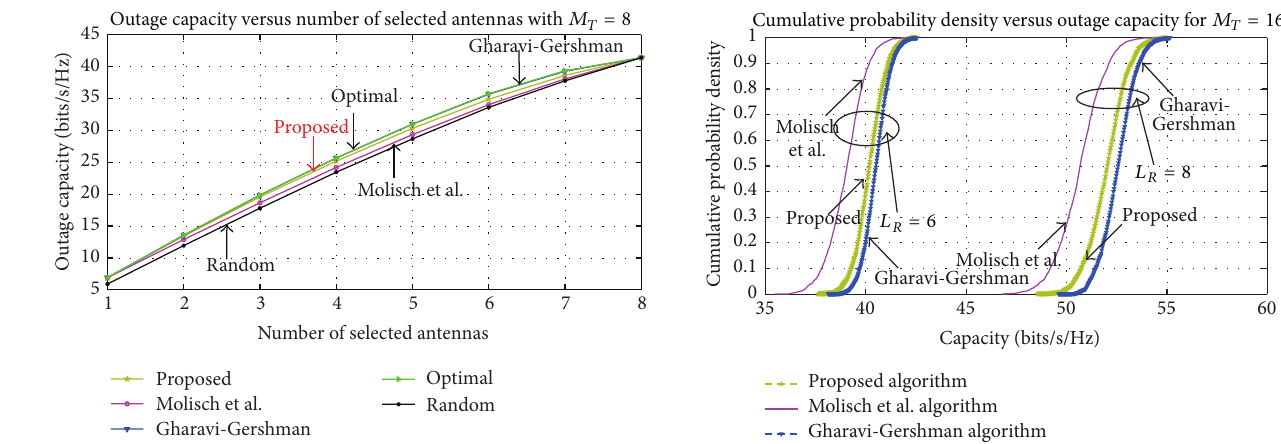
Figure 5: Plots showing the variation of cumulative probability density versus instantaneous capacity for 𝑀 𝑇 = 16 and 𝑀 𝑅 = 16 for 𝐿 𝑅 = 6 and 8 under i.i.d. channel condition.